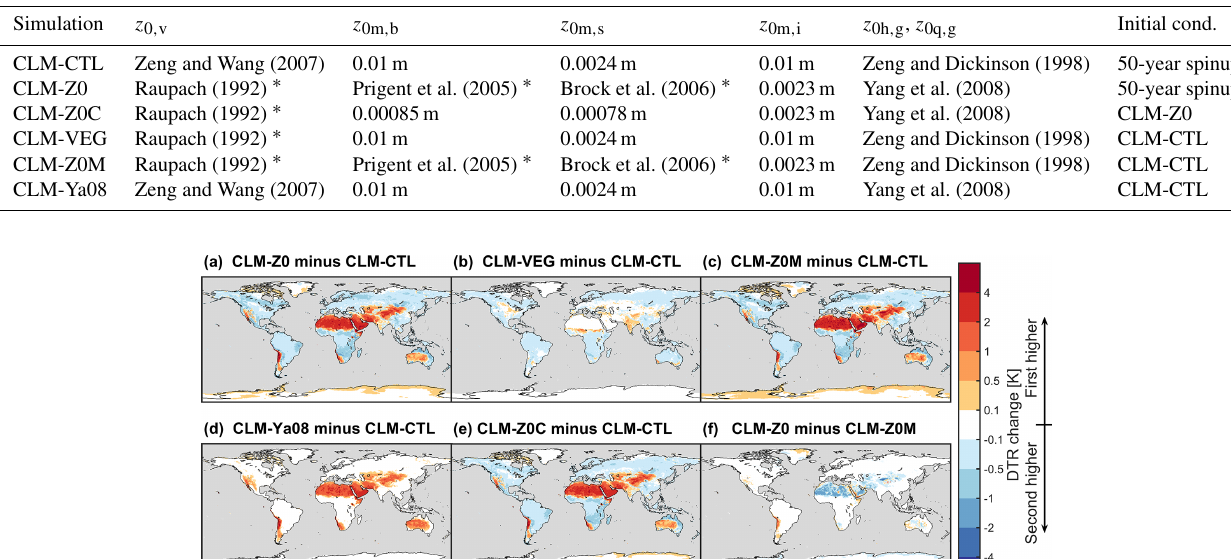
Table A1. Overview of CLM simulations. Columns from left to right show the name of simulation, parameterization for z 0 , v , z 0m , b z 0m , s , choice of z 0m , i , parameterization for z 0h , g and z 0q , g , and initial conditions used. Parameterizations and data sets that are marked with a asterisk were modified before including them in CLM.